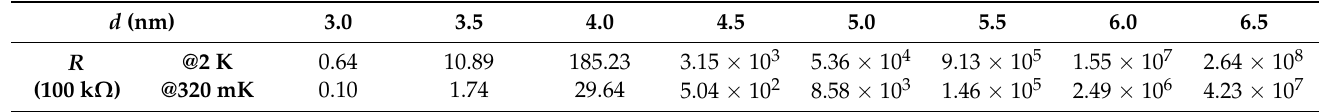
Table 2. Equivalent resistance of barrier with different